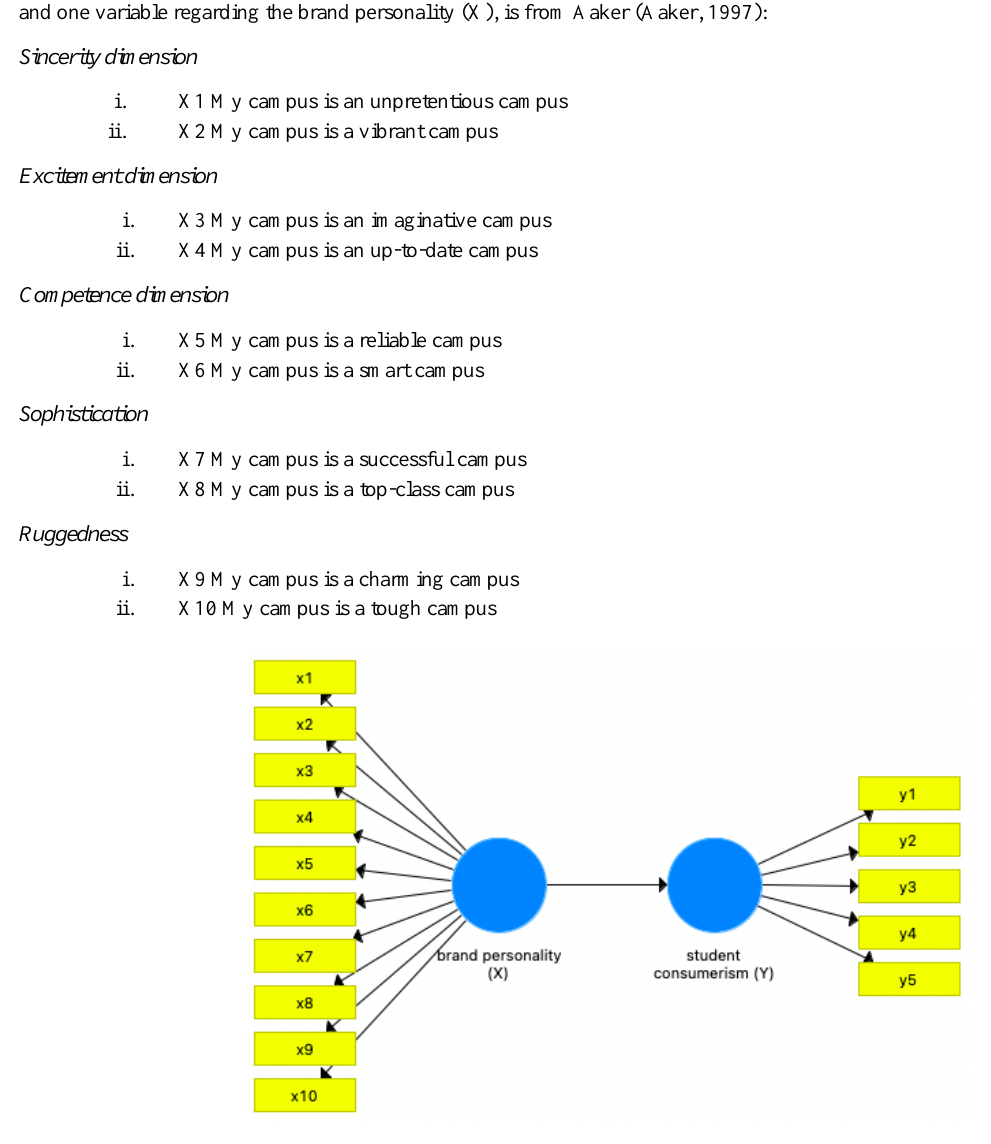
Figure 1: Conceptual Model of the Study; Source: